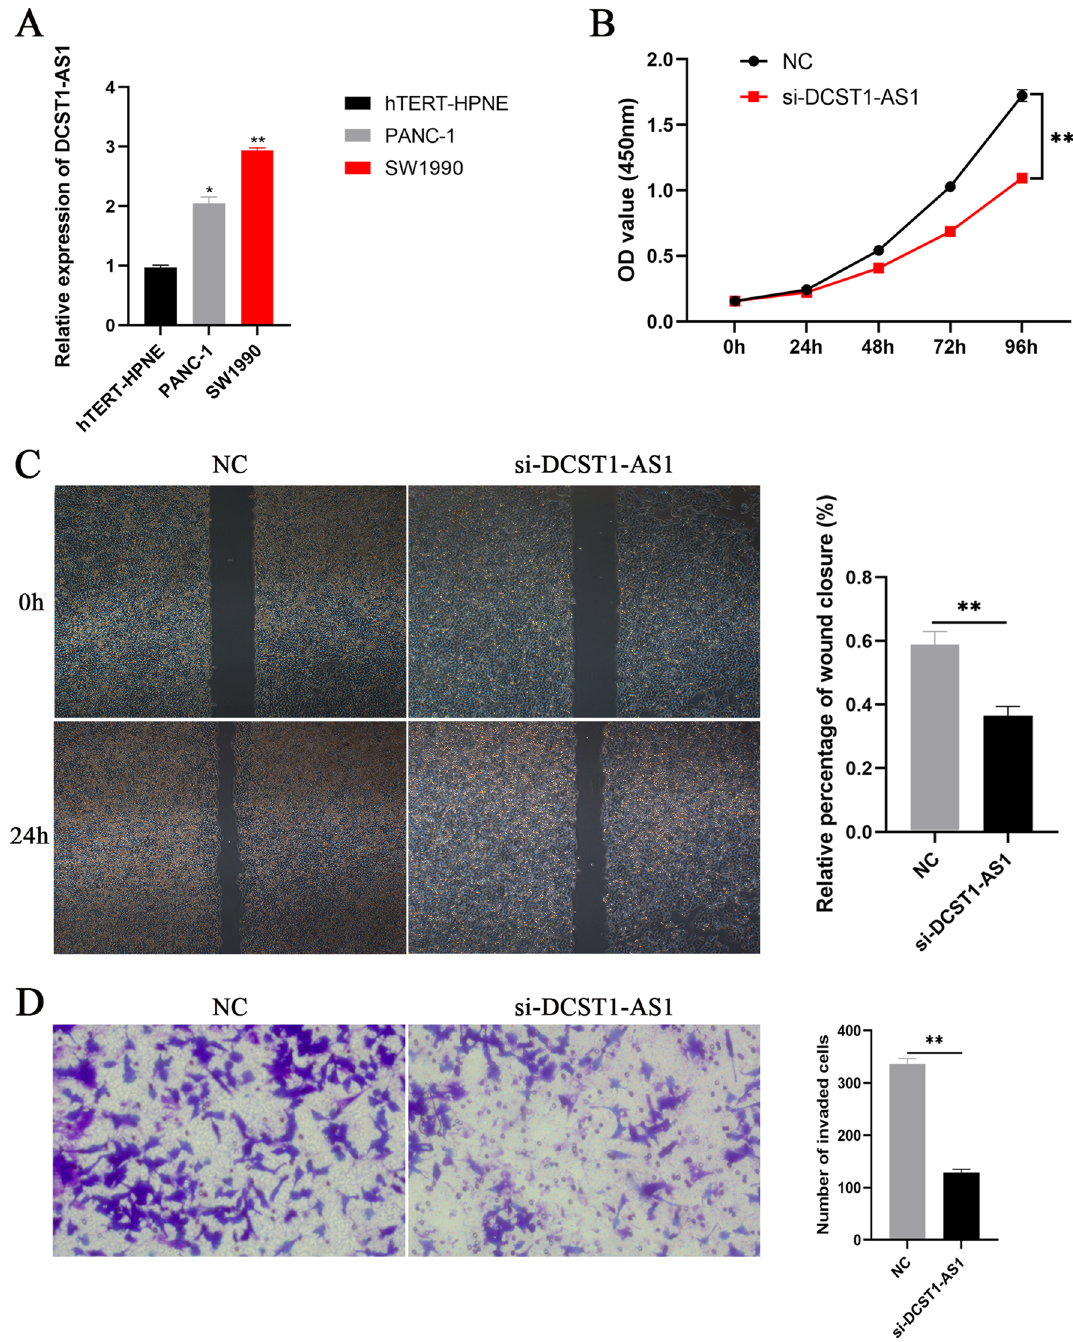
Figure 7. Impacts of DCST1-AS1 knockdown on the proliferation and migration of PDAC cells in vitro. ( A ) The expression of DCST1-AS1 in PANC-1 and SW1990 cells was detected by qRT-PCR assay. ( B ) The viability of SW1990 cells was analyzed by CCK-8 assay. ( C , D ) The migration capability of SW1990 cells transfected with siRNA were measured using wound healing assay and transwell